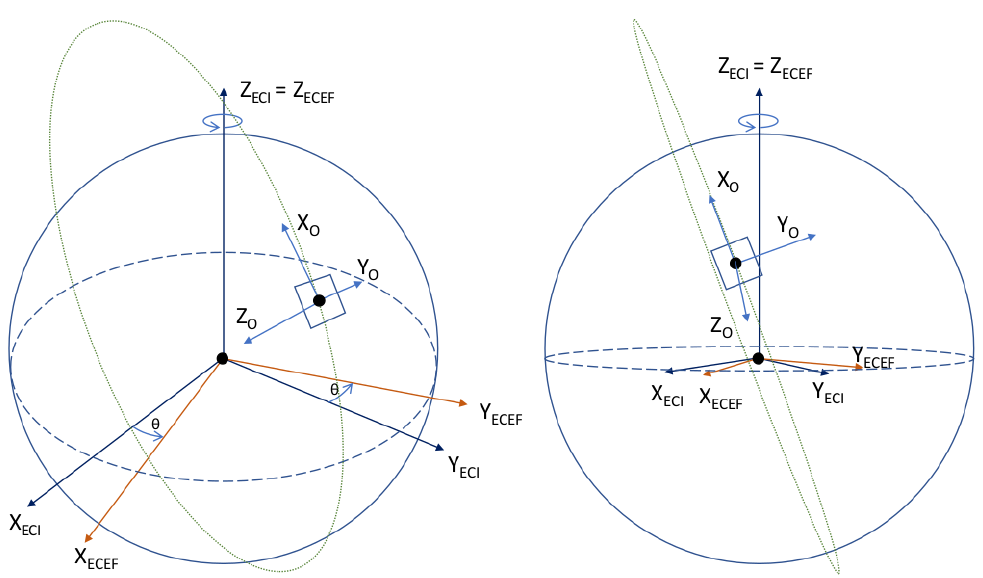
Figure 5. Earth-centered inertial (ECI), Earth-centered Earth-fixed (ECEF), and orbit (O) refer- ence